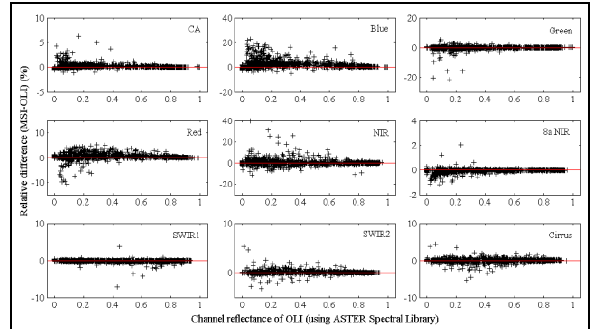
Figure 2. Relative difference in channel reflectance between MSI and OLI, based on a collection including 897 spectra from ASTER Spectral Library Version 2.0. The relative difference in this figure is defined as Eq. (6).